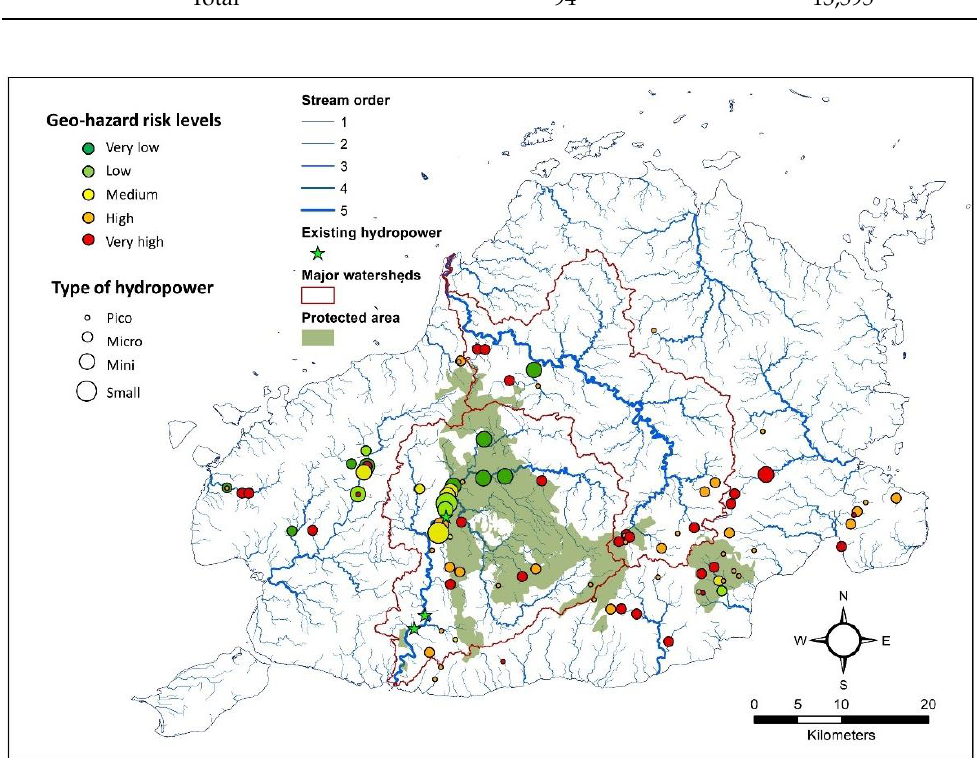
Figure 12. Spatial distribution of the 94 potential small-scale hydropower sites, their types and the geo-hazard risk levels, and the protected area.